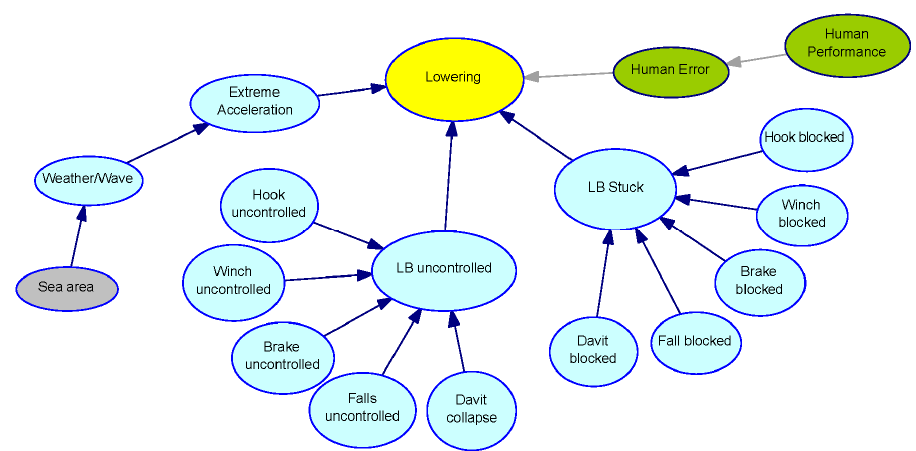
Figure A5. A Bayesian network for transfer and embarkation to lifeboats in fire/explosion accidents (04 FX ).